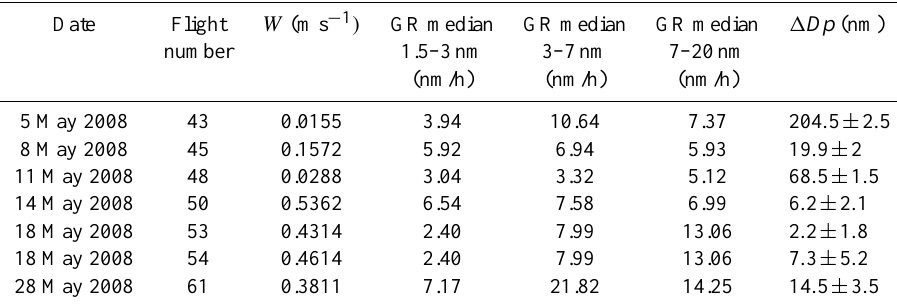
Table 4. Mean vertical component of the wind ( W , ms − 1 ) observed during all detected new particle formation (NPF) events. The estimated median growth rates for nucleation mode charged particles in size ranges 1.5–3, 3–7 and 7–20nm. Calculations are based on ion size distributions measured at the Cabauw field site during the flights. Estimation of the minimum diameter increase ( 1 Dp ) assuming that the particle is formed at the surface site and is transported to the top of the boundary layer. Thus, 1 Dp is calculated using the growth rate, estimated with the NAIS measurements at the Cabauw field site, the mean vertical wind speed ( W ) observed in the BL and the height of the BL given in Table 2 ( 1 Dp = GR · W ·